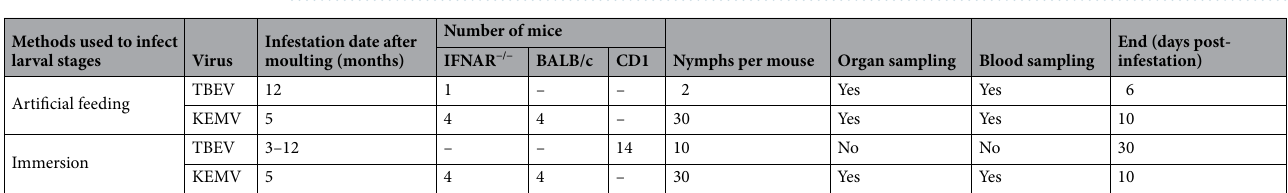
Table 3. Experimental design of virus transmission from nymphs infected at the larval stage to a vertebrate host.